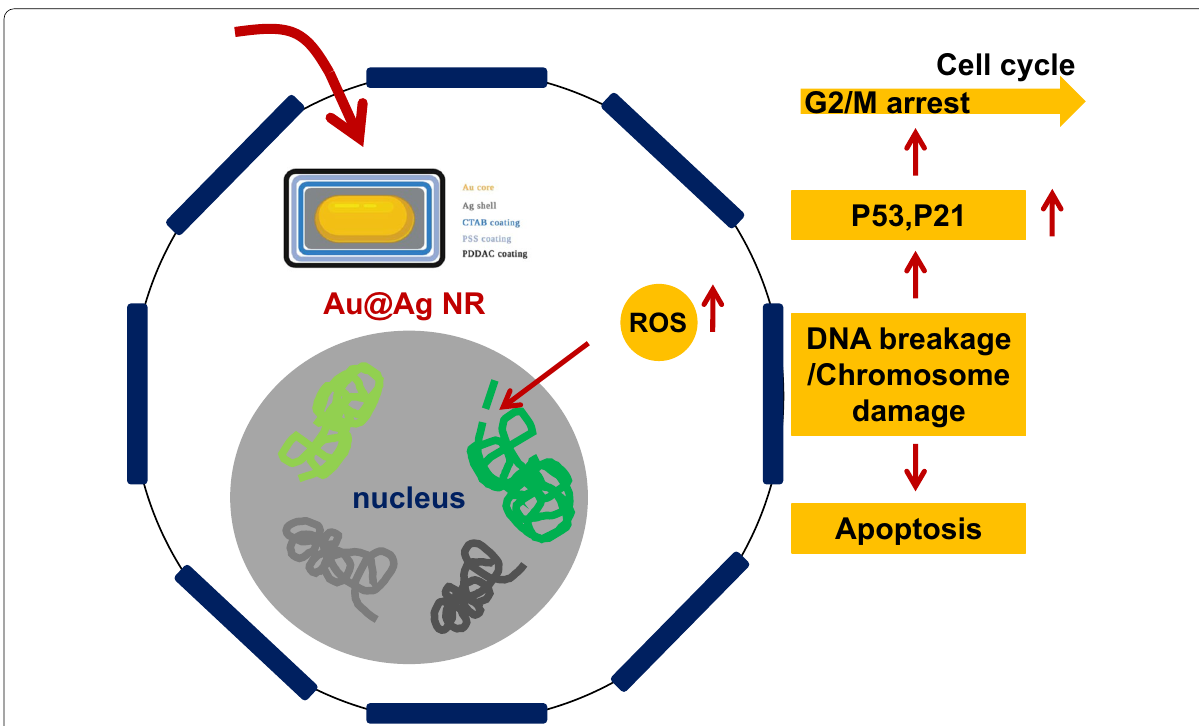
Fig. 7 Schematic diagram of the possible mechanism of genotoxicity introduced by AgNP in